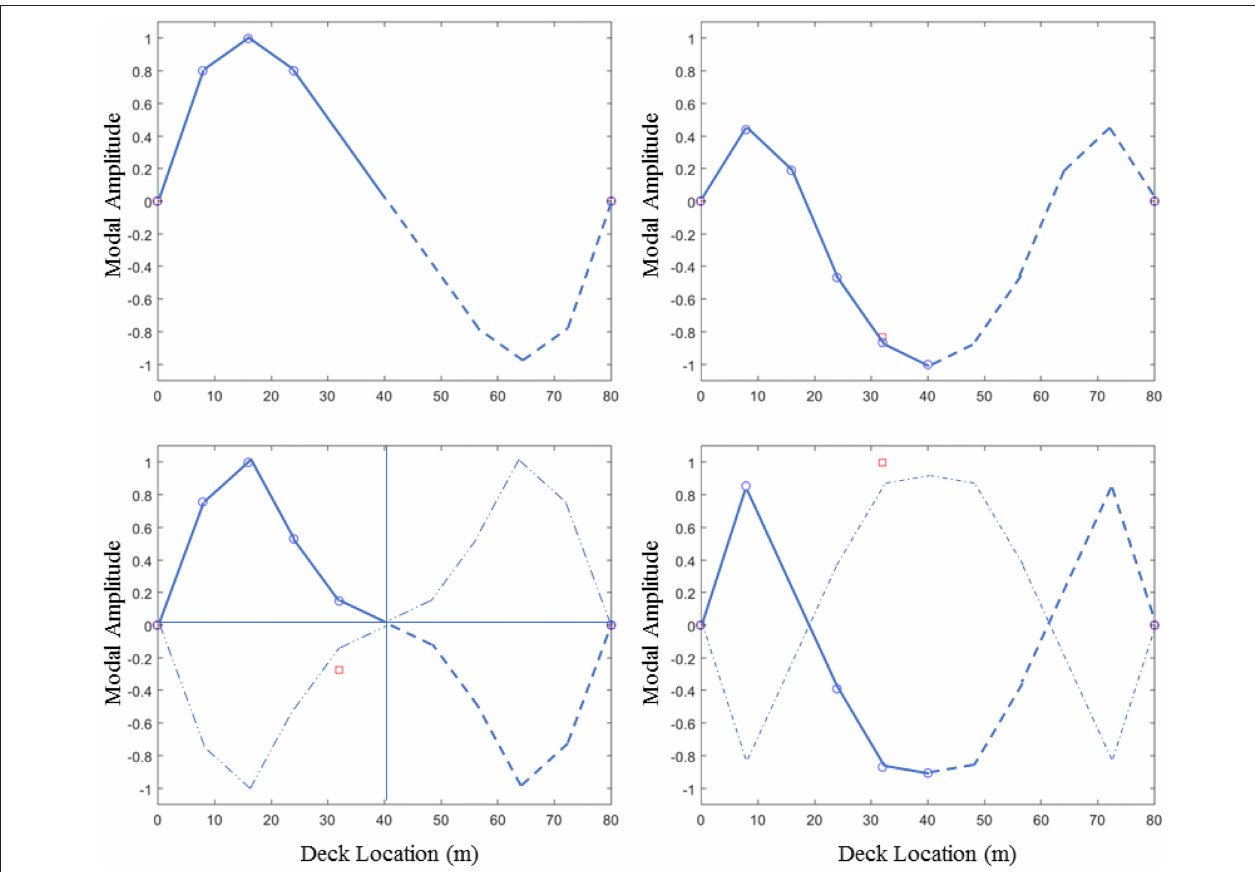
FIGURE 8 | Mode shapes for the Rio Abajo footbridge showing half the span and their reflections around the midspan: VA (top left), VS (top right), TA (bottom left), and TS (bottom right) modes.